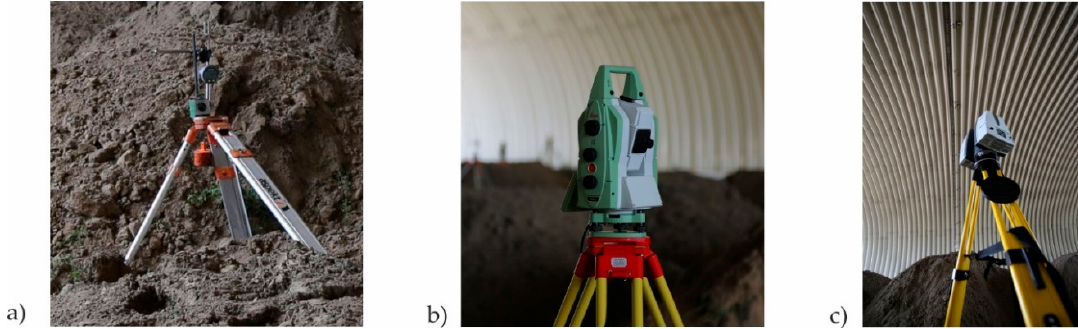
Figure 4. Devices and sensors used to measure basic bridge properties: ( a ) vertical translation inductive sensor, ( b ) total station, ( c ) laser scanner.